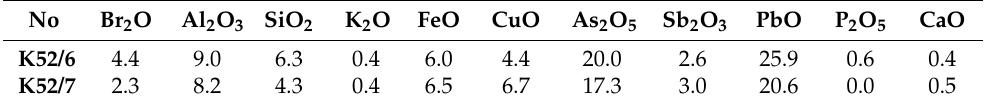
Table 1. Semi-quantitative elemental analysis of selected Sb-bearing grains in azurite paint layer (sample K52) by EDS, expressed in wt% oxygen by stoichiometry.